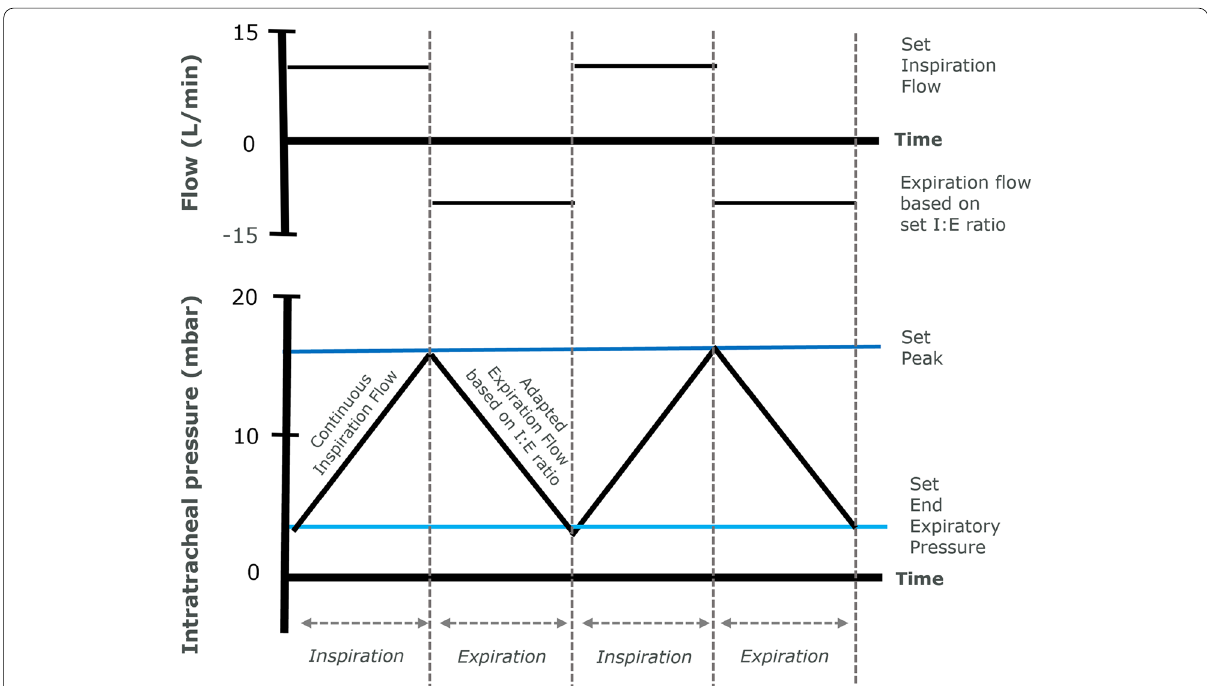
Fig. 2 Setting flow-controlled ventilation (FCV). Using FCV requires the setting of four parameters: (1) inspiration flow, (2) I:E ratio, (3) peak pressure, and (4) end-expiratory pressure (EEP). At the set flow rate, gas is insufflated from set EEP until it reaches the set peak pressure. Then, the flow is reversed and gas is sucked out at the rate to reach the set I:E ratio until EEP is reached, aiming for a linear decrease in intratracheal pressure. Then, a next insufflation with the set inspiration flow is started. Applied tidal volume results from the set driving pressure and respiratory